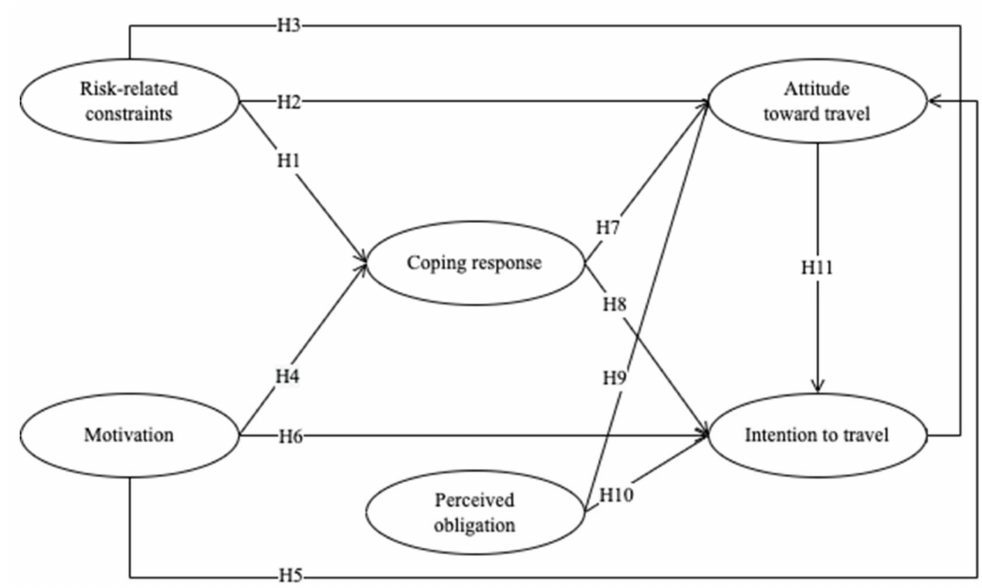
Figure 1. Conceptual